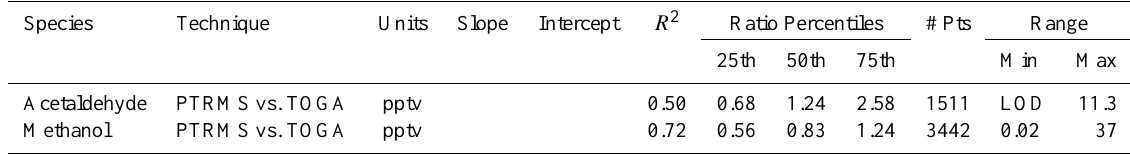
Table 5c. C-130 intra-platform comparison. Oxygenated volatile organic carbons. NOTE: Technique is listed as X vs. Y.